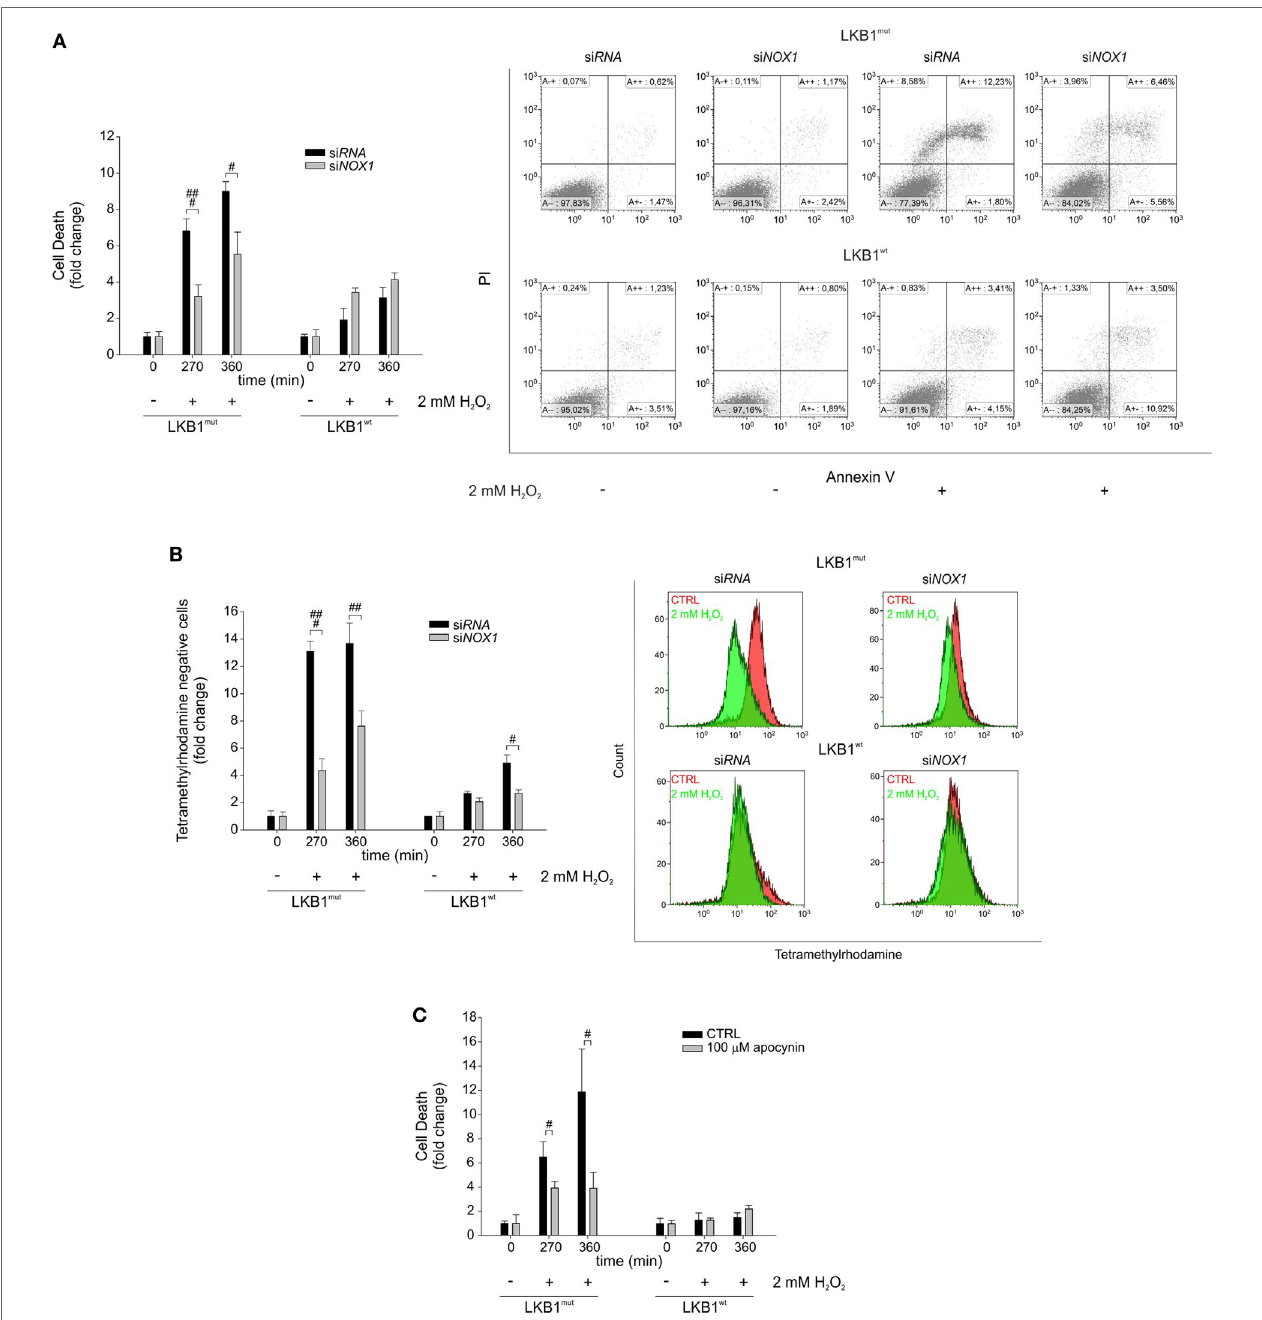
FigUre 3 | NADPH oxidase 1 (NOX1) increases sensitivity to exogenous oxidative stress in vitro . (a) A549 LKB1 mut and LKB1 wt cells were transiently transfected with si RNA targeting NOX1 and cell death was measured upon H 2 O 2 treatment (only statistically significant differences between silenced and control cells are indicated, # P < 0.05, ### P < 0.001). A representative dot plot diagram of Annexin-V/PI stained cells is shown (right panel). (B) Measurement of mitochondrial membrane potential in A549 LKB1 mut and LKB1 wt cells transiently silenced for NOX1 expression (only statistically significant differences between silenced and control cells are indicated, # P < 0.05, ## P < 0.001, ### P < 0.001). (c) Induction of cell death in A549 LKB1 mut or LKB1 wt cells treated with the NOX pharmacological inhibitor apocynin 100 µM upon H 2 O 2 treatment (only statistically significant differences between apocynin-treated cells and control cells are indicated, # P <